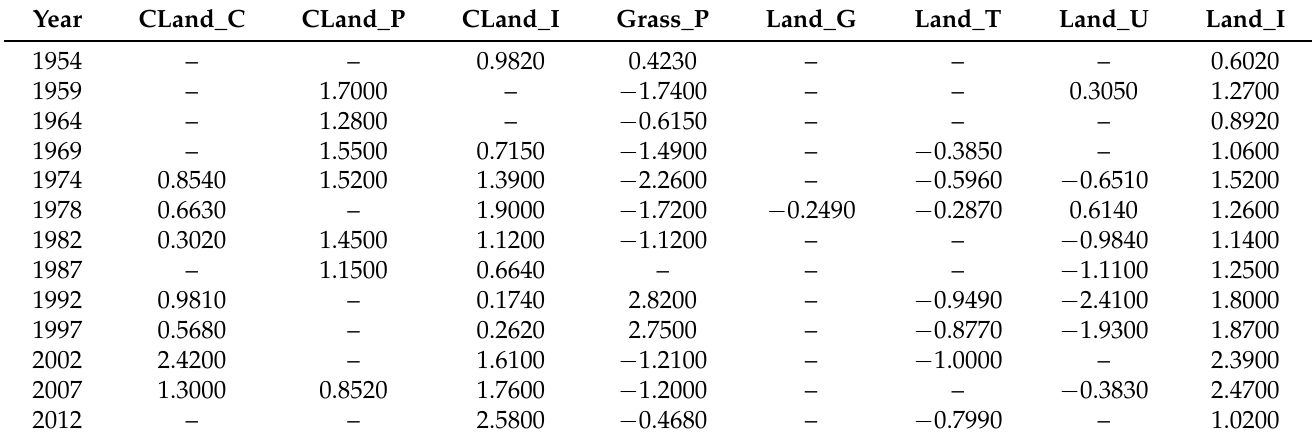
Table 9. Parameter estimates using penalty estimates via SCAD under a spatial logistic model.